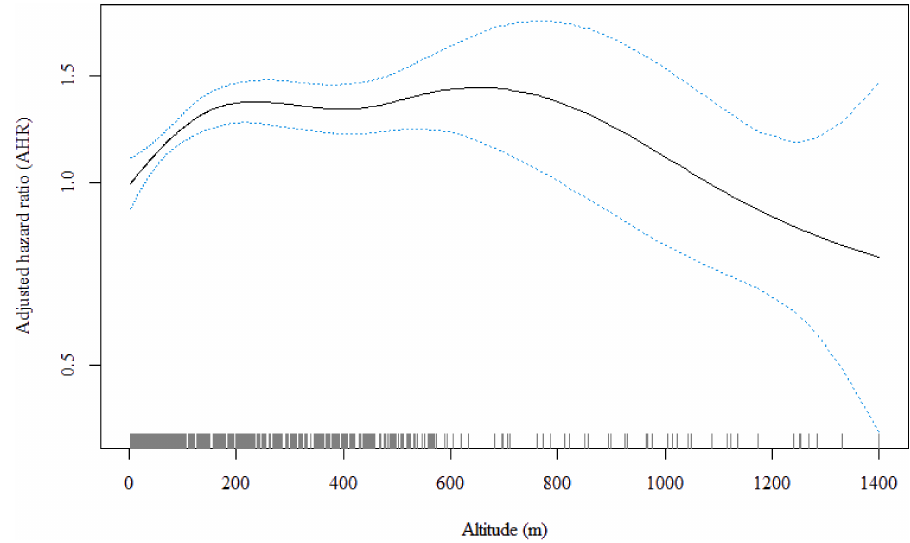
Fig. 3 The visible nonlinear association between residential altitude and hypertension risk (df = 4; reference = lowest altitude of 2.8m). The analysis was adjusted for age, ethnicity, PM 2.5 concentration, residence, geographical region, sex, current smoking status, current drinking status, current exercise habits, pension, marital status, educational attainment, self-reported diabetes, self-reported heart disease, average ambient temperature in January, average annual precipitation, high salt intake, and body mass index. Abbreviations: df, degree of